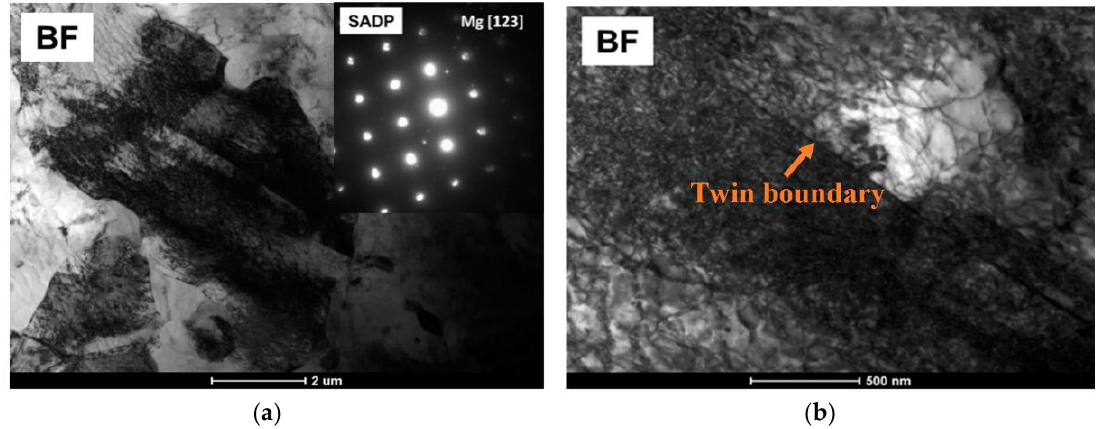
Figure 8. Bright Field (BF) with corresponding SADP TEM microstructure of AZ61 alloy after the first pass: dislocations inside deformed grains ( a ) and twins ( b ).